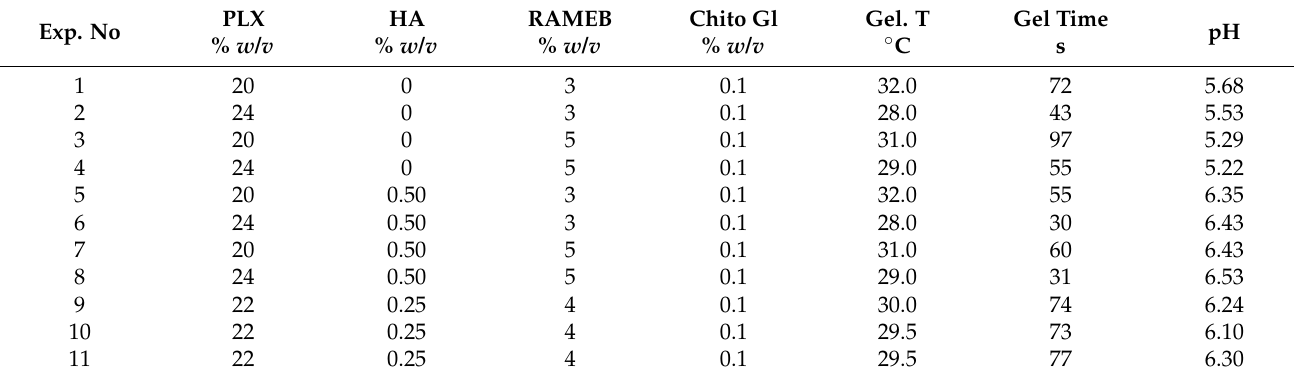
Table 1. Experimental plan and obtained responses (gelation temperature, gelation time, pH). Variables: PLX %, HA %, RAMEB % (fixed component: Chito Gl 0.1%). Exp.